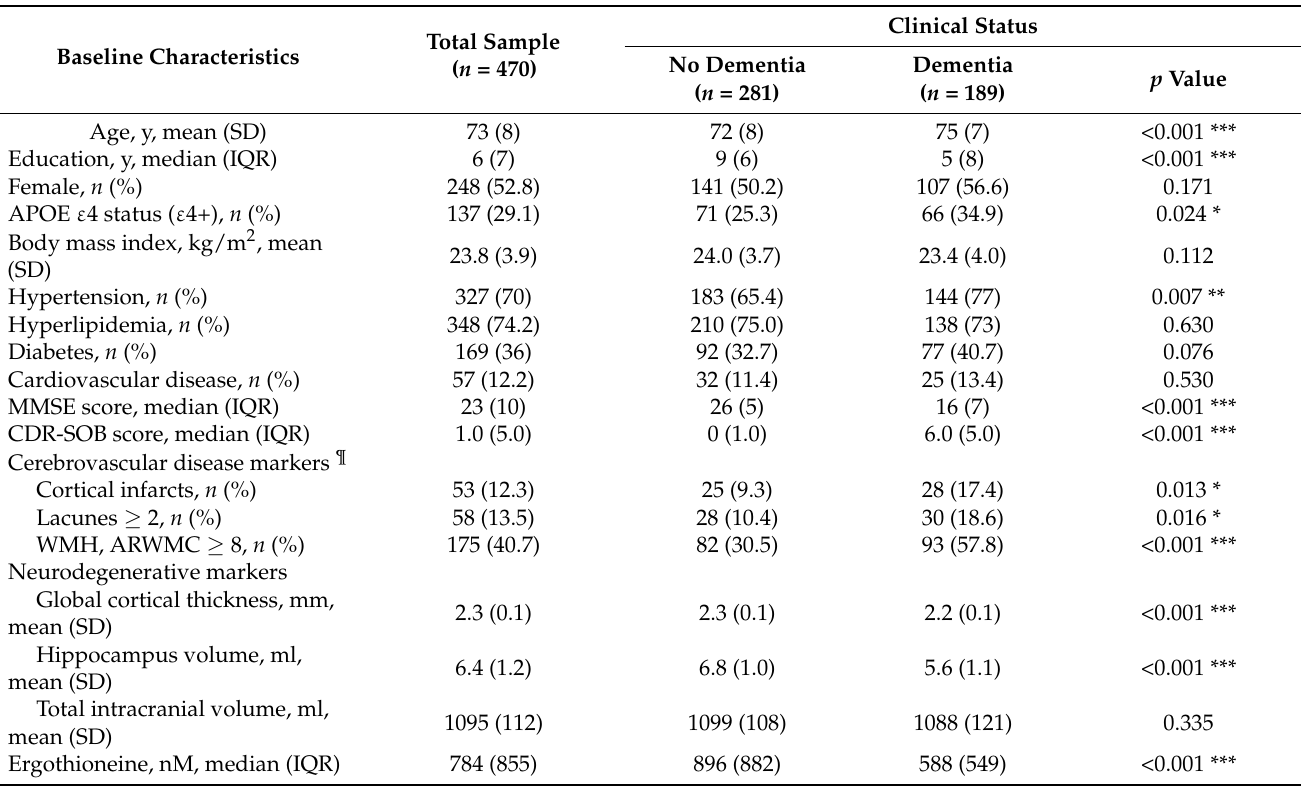
Table 1. Baseline demographics and disease factors of study